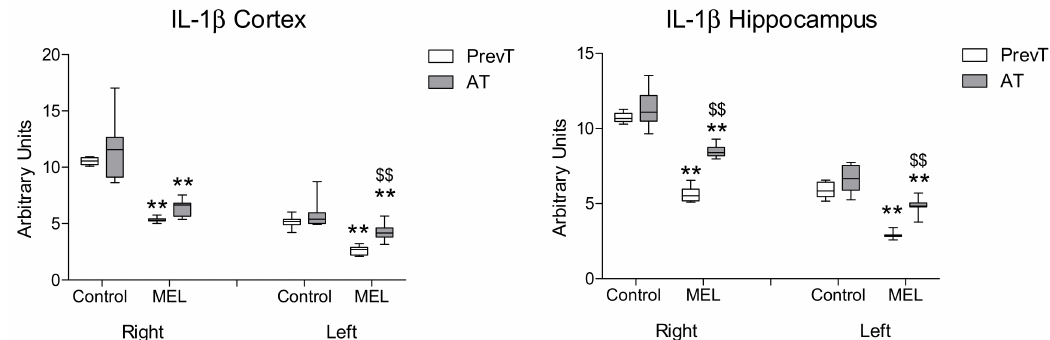
Figure 1. Right and left cortical and hippocampal mRNA expression of IL-1 β in 18-month-old rats in control (non-treated) conditions, after treatment with a daily dose of melatonin (10 mg/kg b.w.) from 24 h before until 7 days after surgery (PrevT), and treated only after surgery during 7 days (AT). Each value represents the median, interquartile and full range of five determinations performed in duplicate. ** p < 0.01 with respect to the values obtained in the control group; $$ p < 0.01 with respect to the values obtained in the PrevT group.